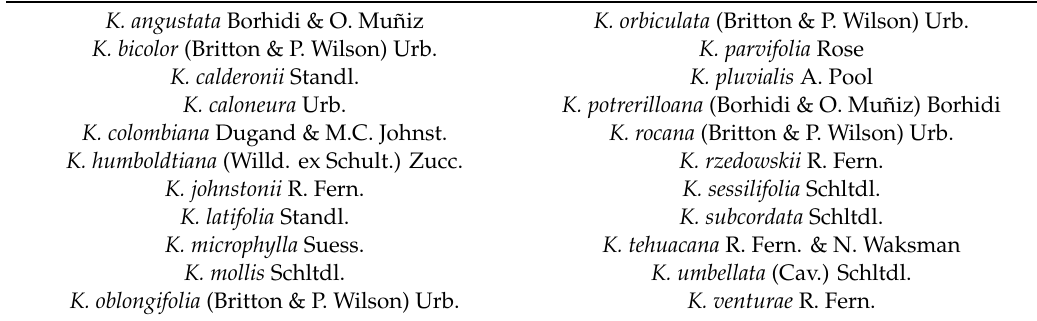
Table 1. Species of Karwinskia